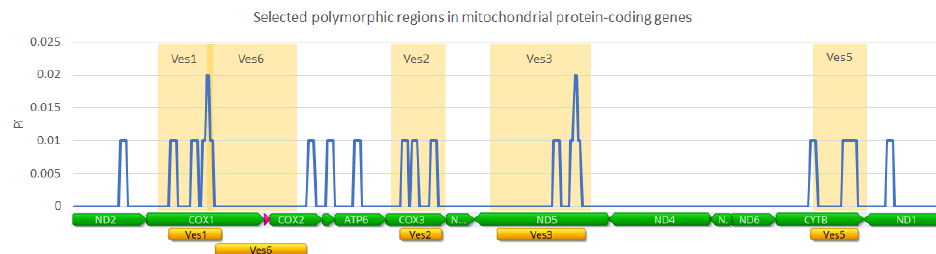
Figure 5. Polymorphic regions were identified in the alignment of four complete mitogenomes of Vespula germanica collected in South Africa, Argentina, and New Zealand. Vertical axis: Pi—nucleotide diversity. Horizontal axis: location of the 13 mitochondrial protein-coding genes (green) and selected polymorphic regions (orange) for Sanger